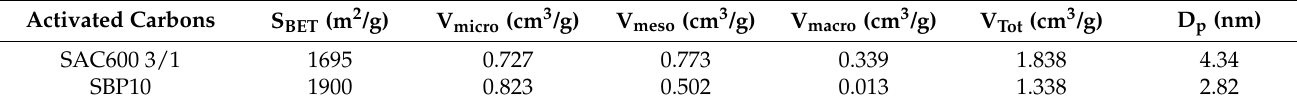
Figure 3. ( a ) Pore size distribution using HK method for both AC. D values between 0 and 240 nm. ( b ) Micropore analysis: D values between 0.6 and 2.0 nm. Based on the pore size distribution calculated from the adsorption isotherms using the HK model, the corresponding average pore sizes of SAC600 3/1 and SBP10 were 0.6 nm and 0.8 nm. Table 1 summarizes the textural properties of both activated carbons. Table 1. Textural properties for SAC600 3/1 and